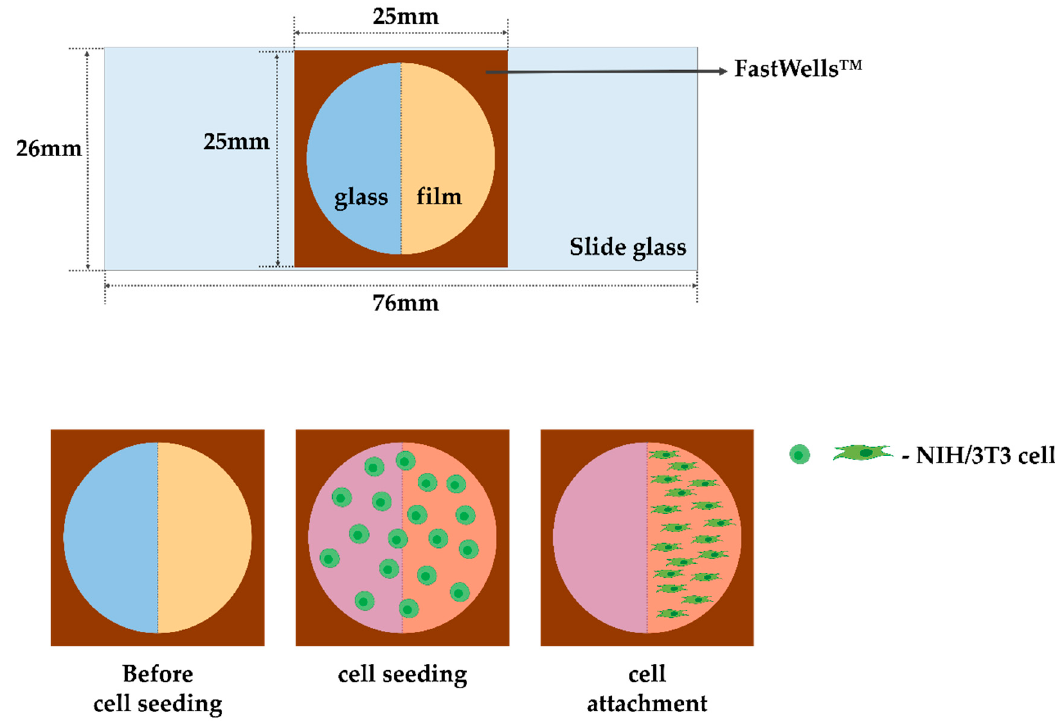
Table 2. Various concentrations of crosslinking agent used in this study. Concentration of CaCl 2 (in 10 mL of 95% Ethanol) 1% ( w/v ) 3% ( w/v ) 5% ( w/v